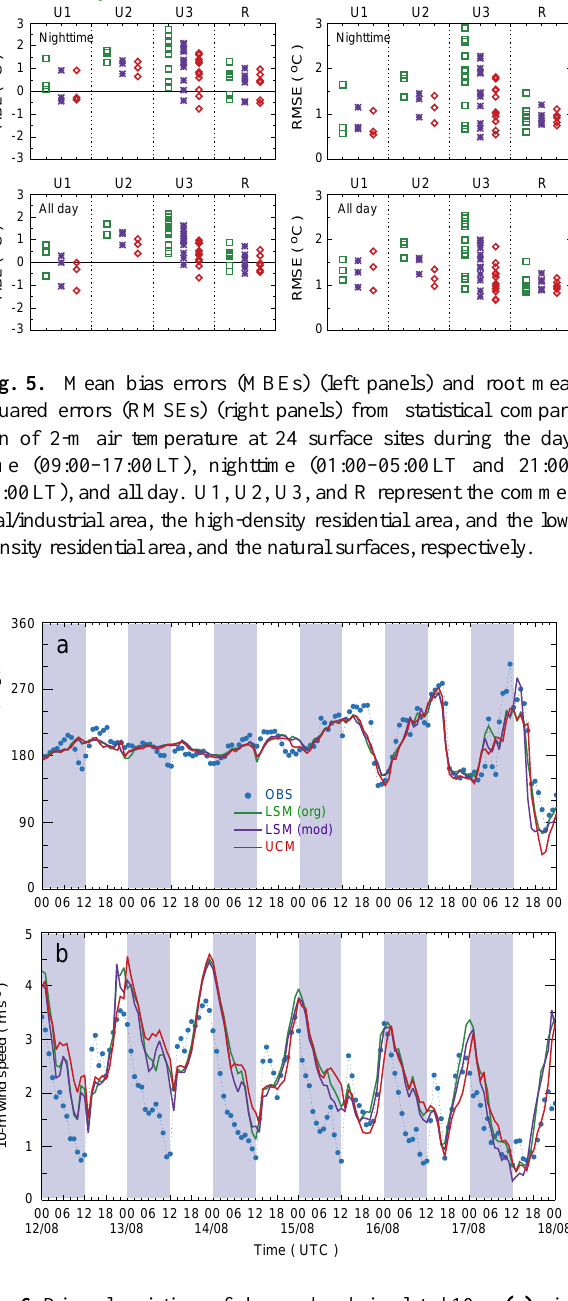
Fig. 6. Diurnal variations of observed and simulated 10-m (a) wind direction and (b) wind speed from 12 to 17 August. The wind fields from 17 urban surface sites in Houston are averaged. Nighttime periods are